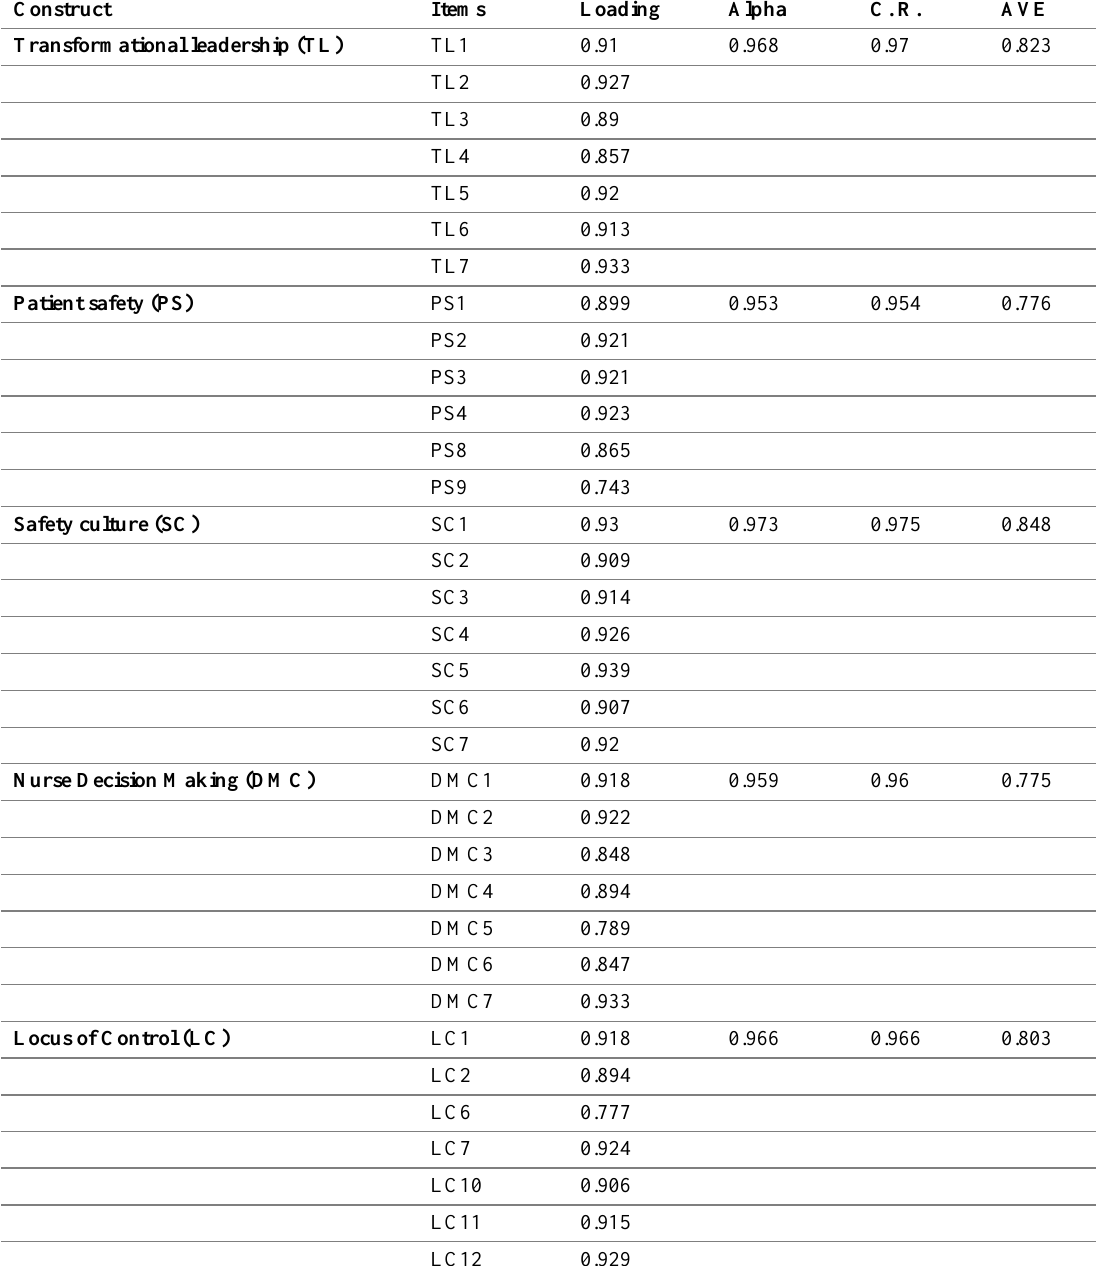
Table 2: Evaluation of outer model